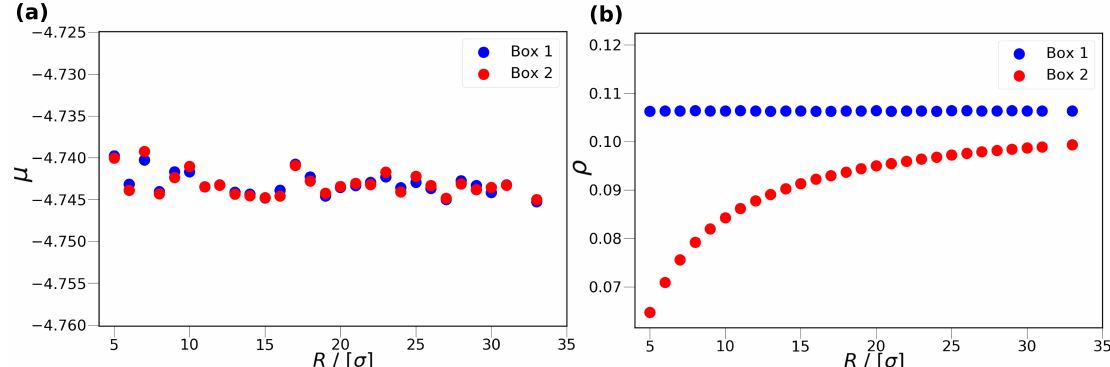
Figure 2. The chemical potential ( a ) and density ( b ) of the bulk, Box 1, and confined fluids, Box 2, as a function of the cylinder radius, R , at P = 0.2 (in Simulation Box 1). The blue and red colors represent Box 1 and Box 2, respectively. The temperature is fixed at T = 2. All values are presented in reduced units. The error bars are smaller than the symbol